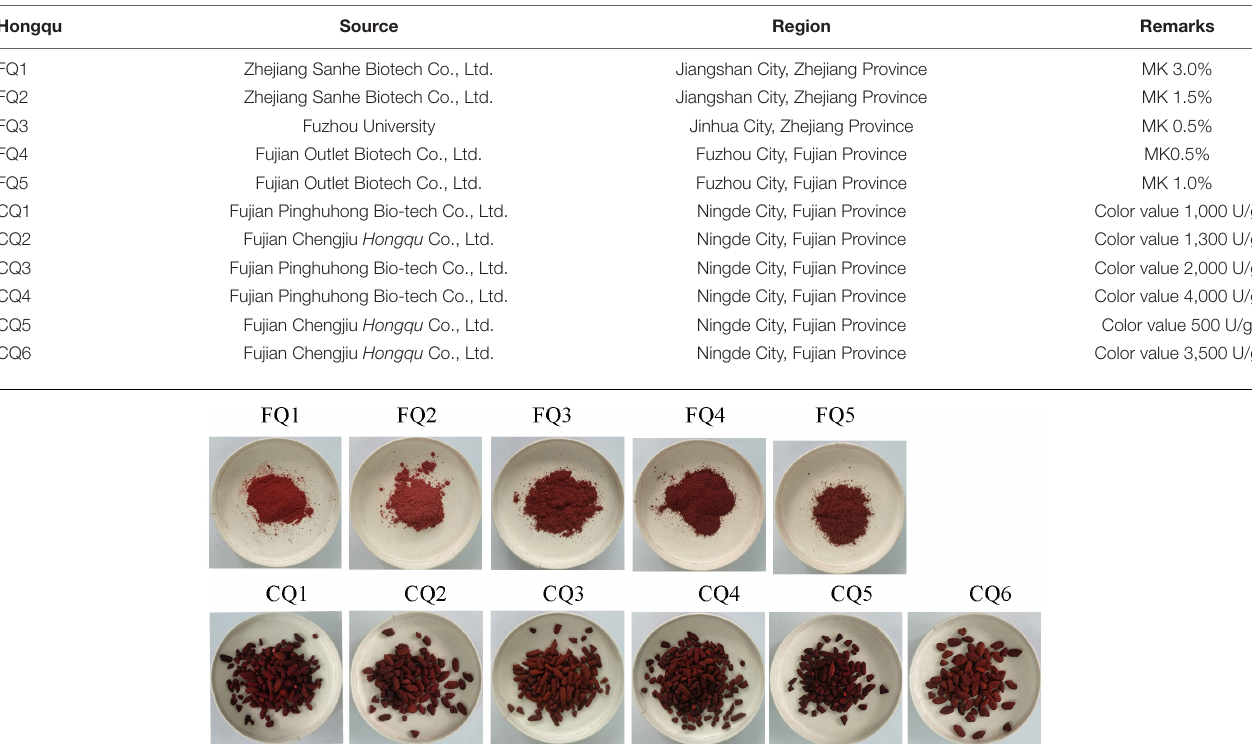
TABLE 1 | The source and region of Hongqu .